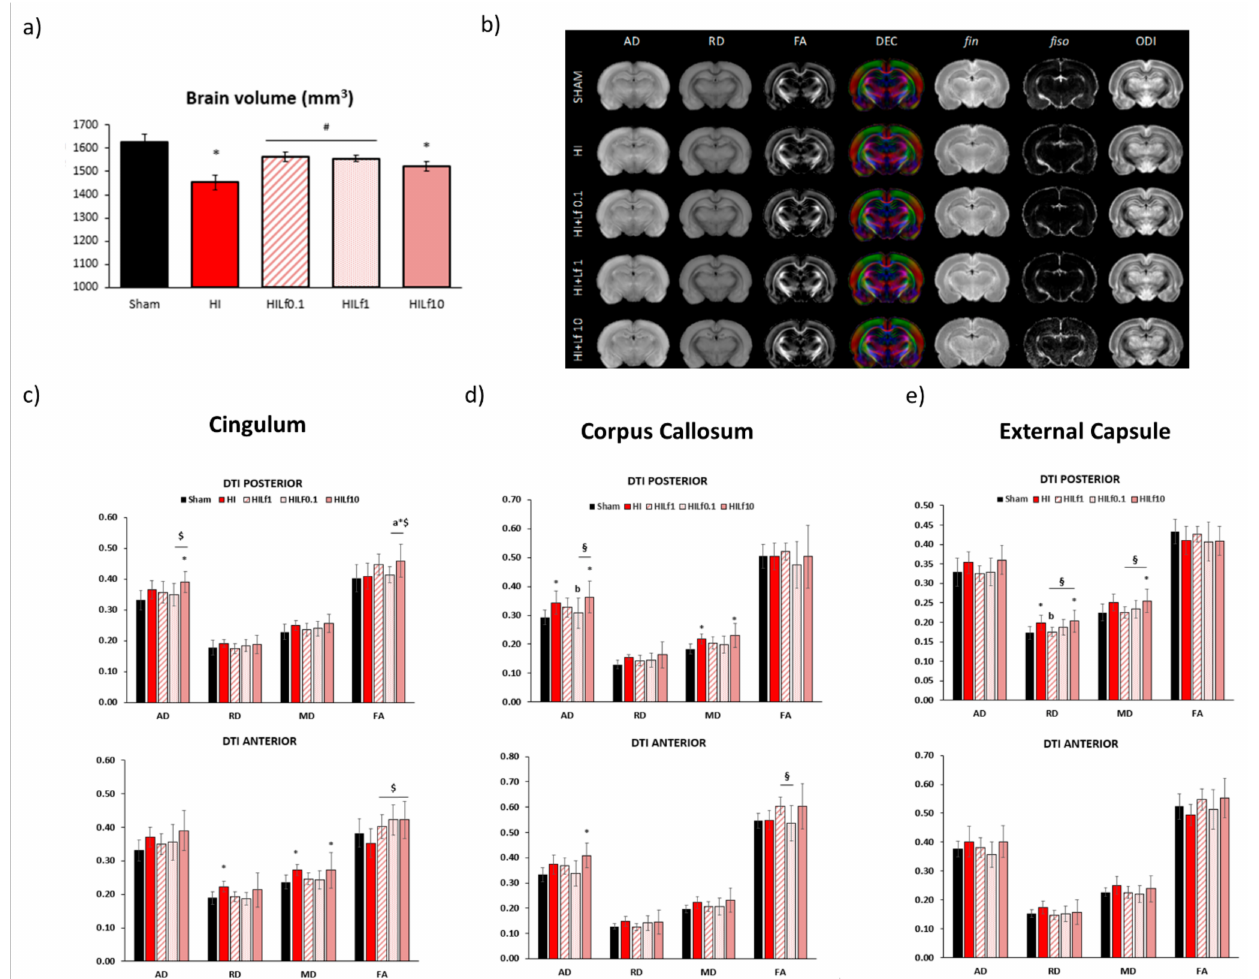
Figure 4. MRI data at P25. Left upper panel ( a )—brain volumes (mm 3 ) ( n = 5–8 animals/group). Right upper panel ( b )—Diffusivity (mean, MD; axial, AD; radial, RD), fractional anisotropy (FA) and direction encoded colour (DEC) maps, intra-neurite volume fraction (fin), cerebrospinal volume fraction (fiso), and orientation dispersion index (ODI) maps. Maps correspond to the averaged maps over each group. Lower panels: histogram of diffusivities (mean, MD; axial, AD; radial, RD; × 10 − 4 mm 2 · s − 1 ) and fractional anisotropy (FA) in the cingulate gyrus (left panels— c ), corpus callosum (central panels— d ) and external capsule (right panels— e ). Results are mean ± SD. * HI vs. SH, $ difference between HILf groups. a b HILF0.1, or 1 vs. HI, respectively. Differences were determined by one-way ANOVA and considered significant when p < 0.05 ( n = 5–8